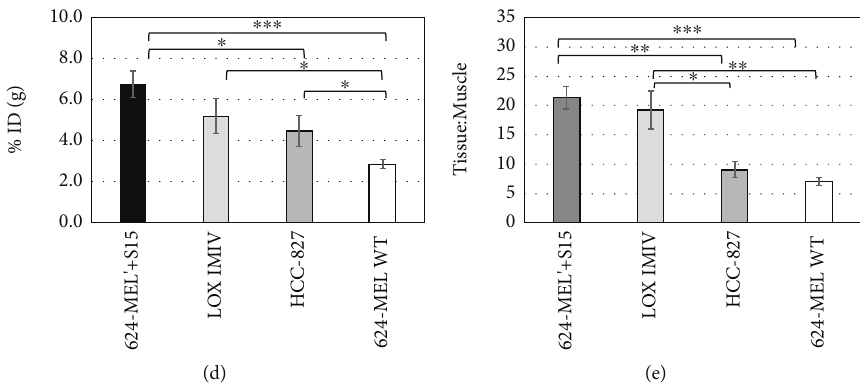
Figure 5: (a) Biodistribution (%ID/g) of [ 89 Zr]Zr-DFO-NC318 in 624-MEL+S15 xenografts at 3d after receiving coinjections of [ 89 Zr]Zr- DFO-NC318 ( ~ 0.8 μ g) + NC318 (0 (control), 20, 100, and 300 μ g). Each bar represents the mean % ID/g ± SE ( n = 5 -10 for each group). (b, c) [ 89 Zr]Zr-DFO-NC318 tissue (%ID/g) to blood (%ID/g) ratios (T:B; (b )) or tissue (%ID/g) to muscle (%ID/g) ratios (T:M; (c)) in 624- MEL+S15 xenografts 3d after receiving coinjections of [ 89 Zr]Zr-DFO-NC318 ( ~ 0.8 μ g) + NC318 (0 (control), 20, 100, and 300 μ g). Each bar represents the mean ratio ± SE ( n = 5 -10 for each group); ∗ P < 0 : 05 ; ∗∗ P < 0 : 01 ; ∗∗∗ P < 0 : 001 (Student ’ s t -test): indicates a signi fi cant di ff erence between the T :B (b) or T :M (c) ratios of each NC318-dosed group compared to respective [ 89 Zr]Zr-DFO-NC318 controls (0 NC318 μ g dose) in Siglec-15+ tissues (lymph nodes, spleen, tumor, and femur). (d, e) [ 89 Zr]Zr-DFO-NC318 tumor uptakes (%ID/g (d)) and T :M ratios (e) in 624-MEL+S15 ( n = 9 ), LOX IMIV ( n = 9 ), HCC-827 ( n = 6 ), and 624-MEL wild-type (WT; n = 9 ) xenografts after di ff erence between the %ID/g (d) or T: M (e) ratios between the indicated 2 tumor